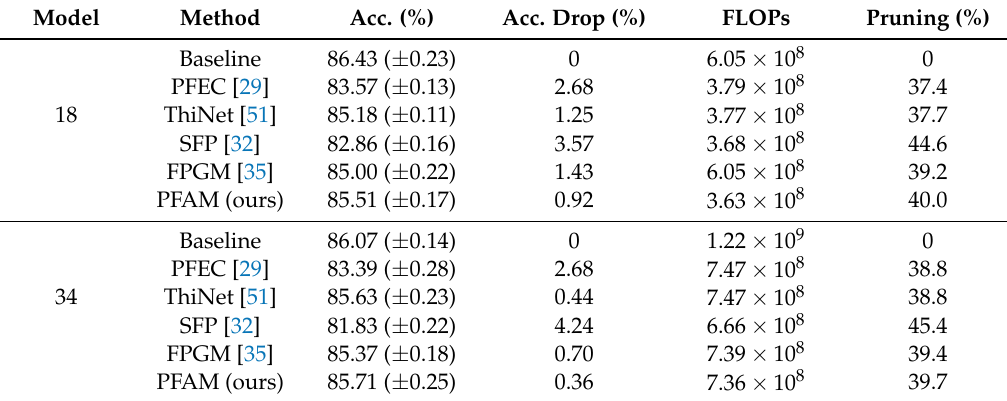
Table 6. Comparison of pruning ResNet on the RSSCN7